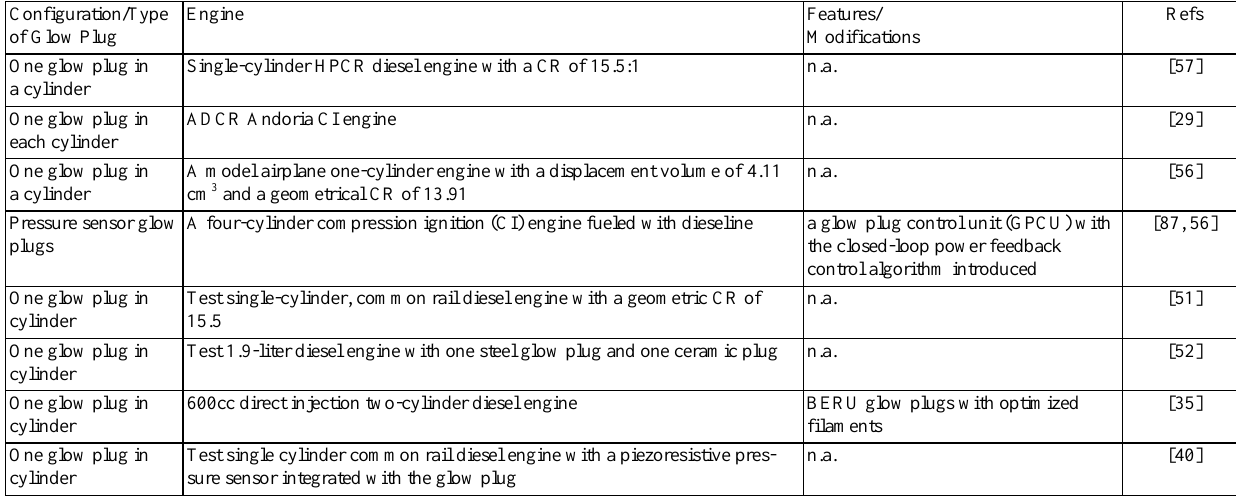
Table 2. The application of glow plugs for CI engines